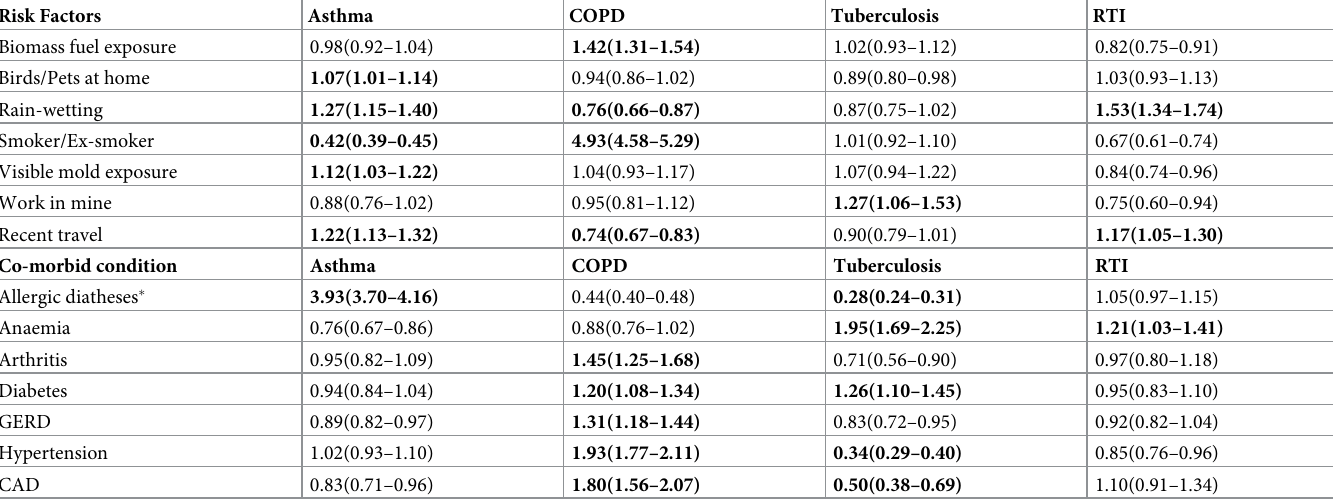
Table 2. Association of the major respiratory diagnoses with risk factors and co-morbid